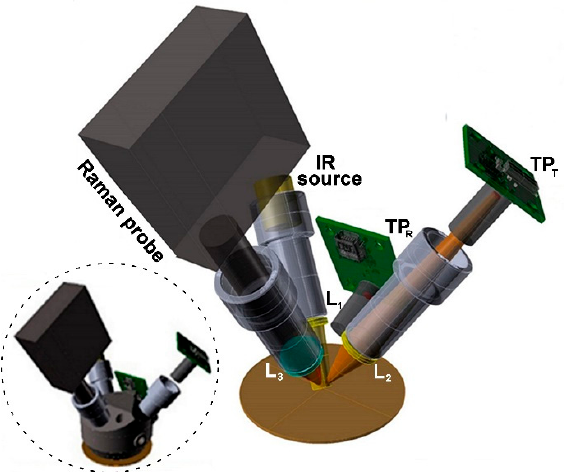
Figure 1. Schematic setup of the thermally controlled Raman probe including emissivity and tem- perature measurements channels (see the text). The four radiation channels were housed in the in- tegrating sphere shown in the inset.